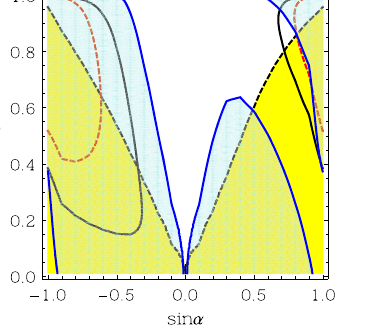
Fig. 6 The extent of parameter space admissible (regions in yellow) after demanding that the rates for the gg → γγ (left), and the gg → h → WW ∗ / Z Z ∗ (right) match the experimentally reported values for the 125 GeV higgs for the case of the light higgs h being SM-like. Also overlaid in each plot are the corresponding regions in the Type I 2HDM (regions enclosed by the blue contours). The dashed red contours are the ATLAS h → b ¯ b limits